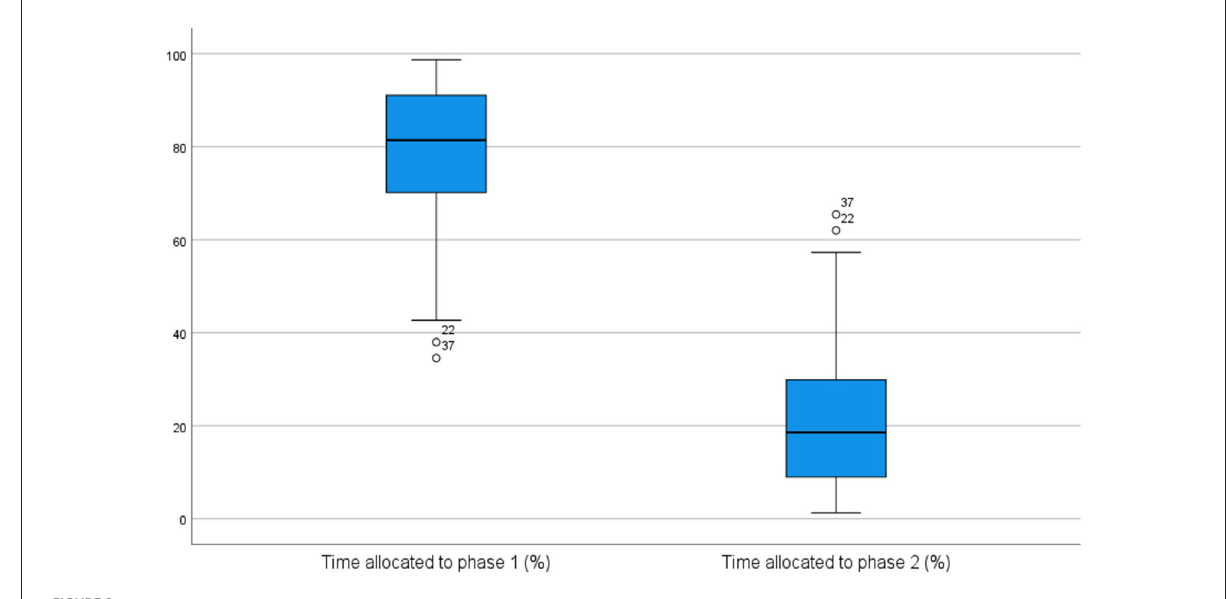
FIGURE2 Time distribution across phases in pre-test session.